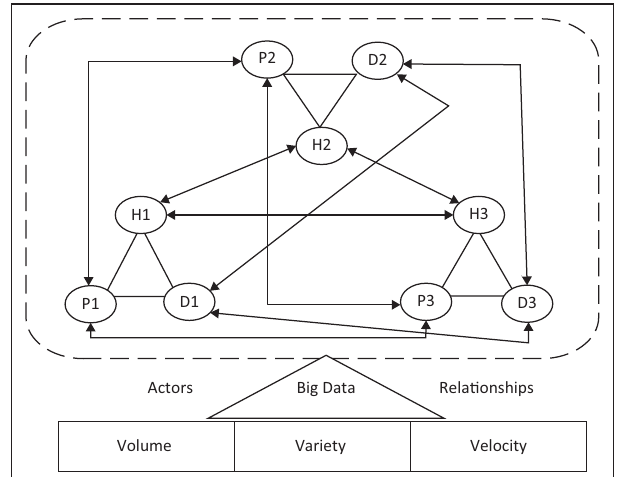
FIGURE 3: Heterogeneity of big